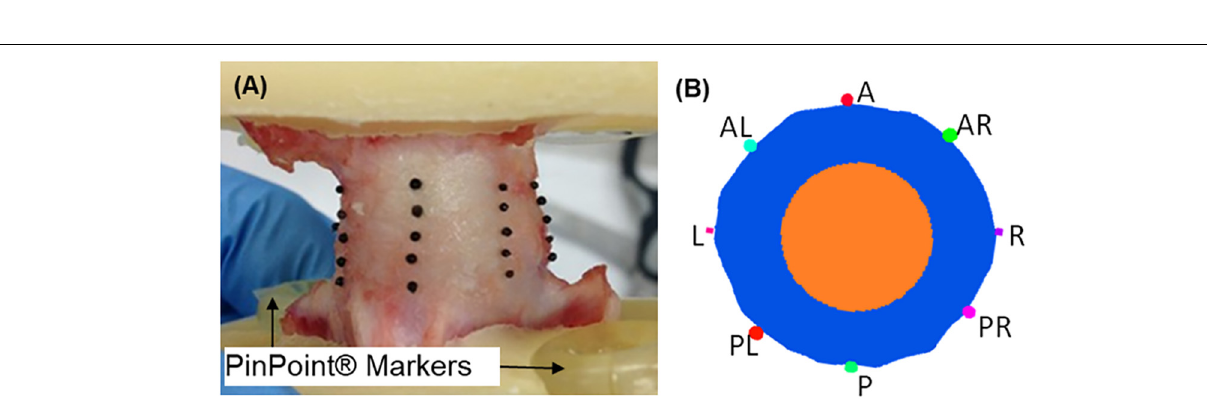
FIGURE 1 | Overview of the experimental in vitro and computational in silico arms of the study.